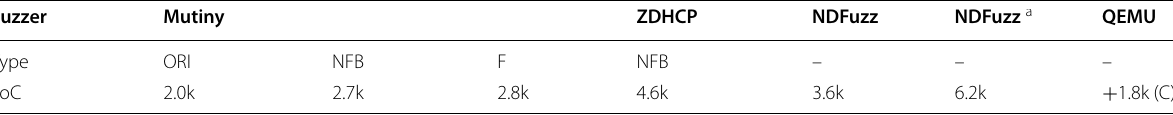
a Contains well-adapted ZDHCP-FB